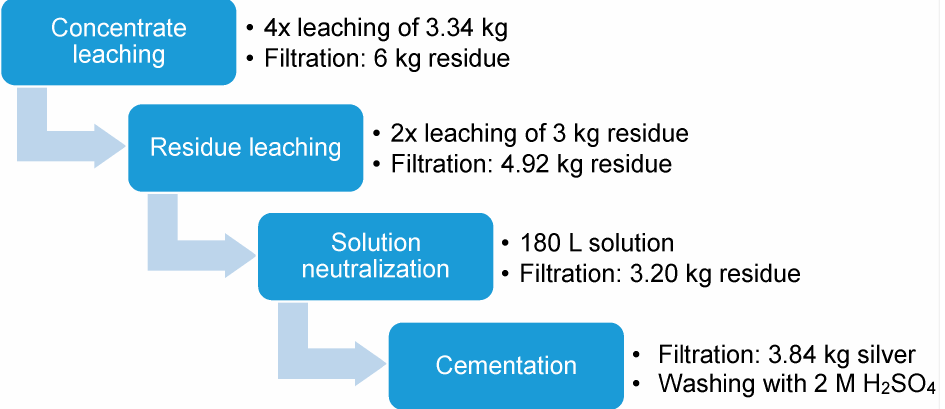
Figure 2. Overview of upscaling procedure.